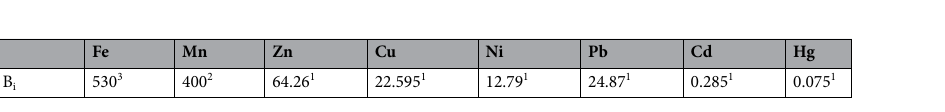
Table 3. The background values of risk elements in mg/kg. 1 According to Linkeš et al. 50 . 2 According to He et al. 51 . 3 According to Demková et al. 52